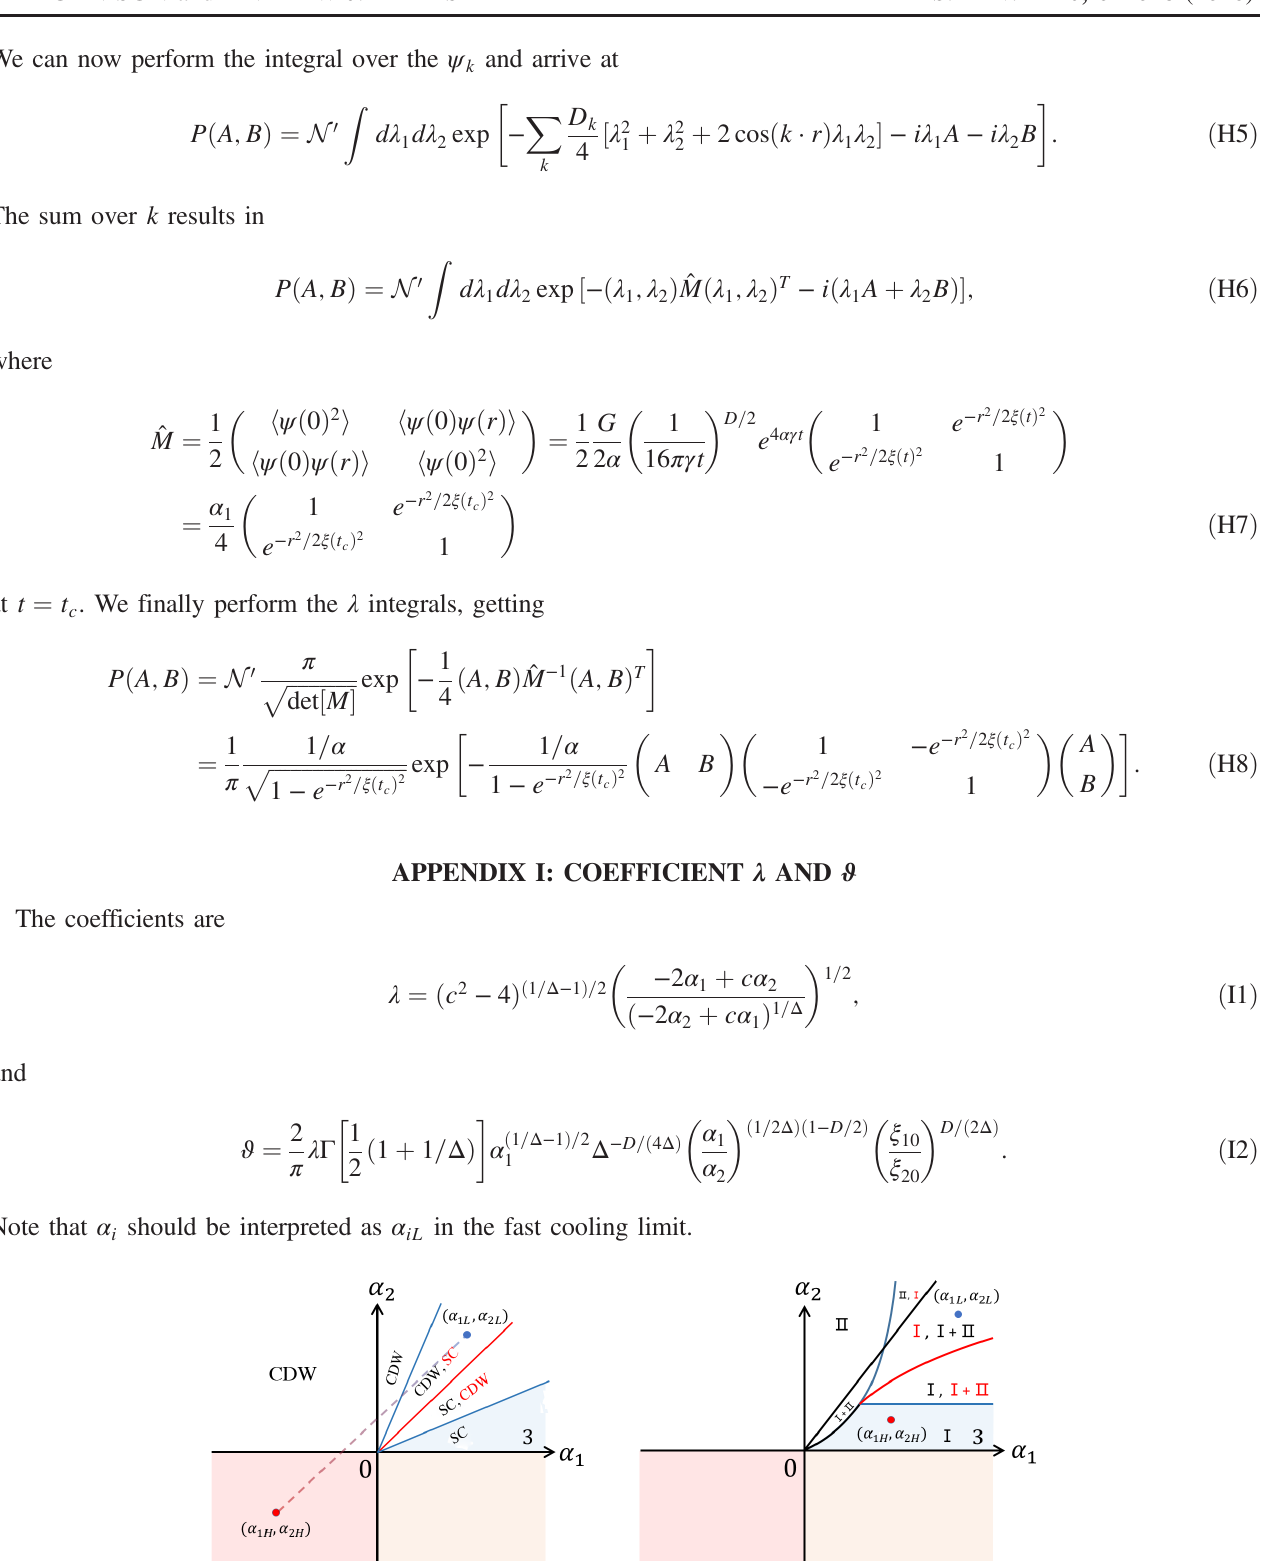
FIG. 10. Nonequilibrium phase diagram for the pumped parameter α the system can be trapped into the metastable SC sate. Dashed line is the trajectory of α